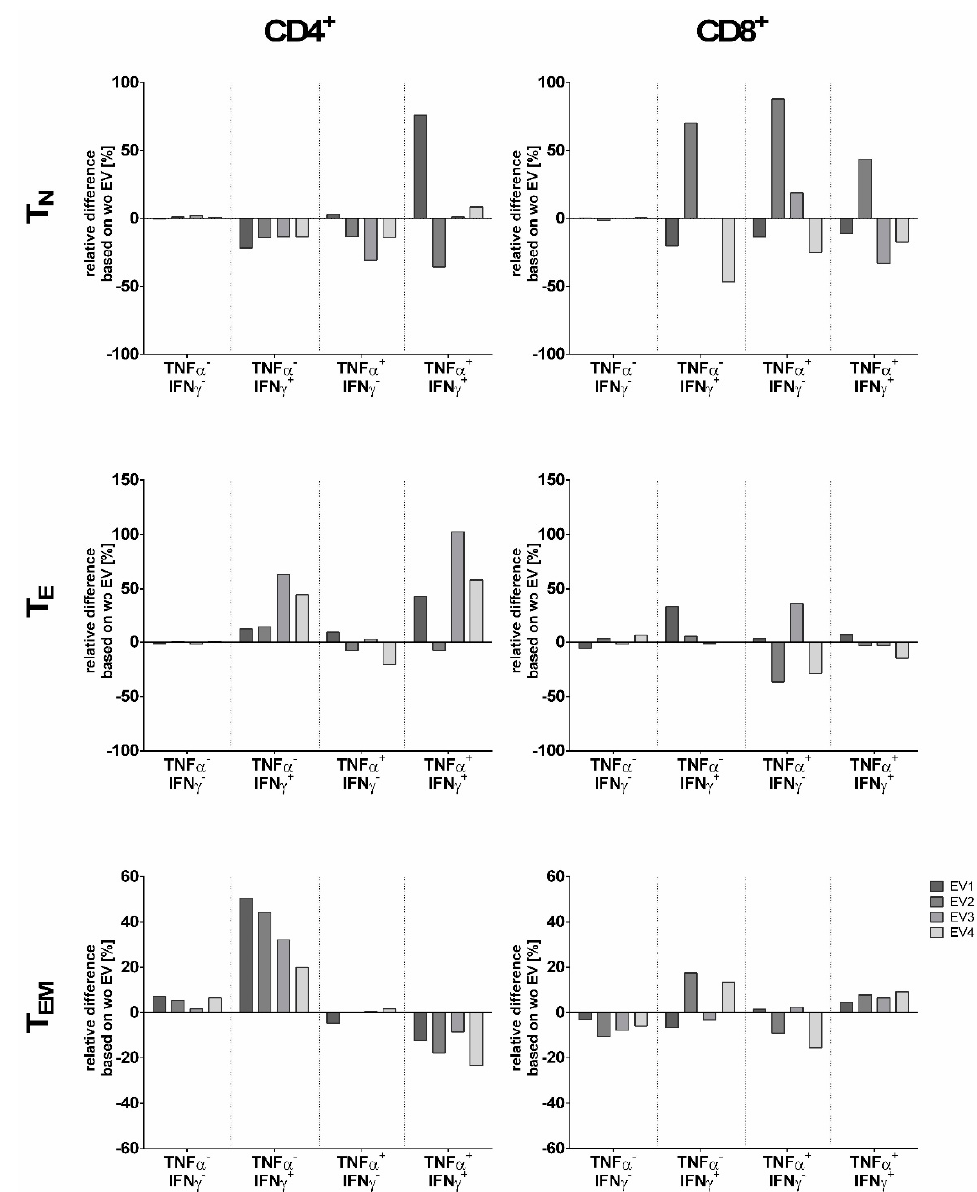
Figure 4. Modulation of the cytokine response of T cells subsets by MSC-EVs. Effect of different MSC-EV (EV1–EV4) on the proinflammatory cytokine distribution pattern of CD4 + and CD8 + naïve (T N ), effector (T E ) and effector memory (T EM ) T cell subsets upon 4 h of PMA/Ionomycin stimulation. Given are the relative differences normalized to the stimulation in absence of MSC-EV.